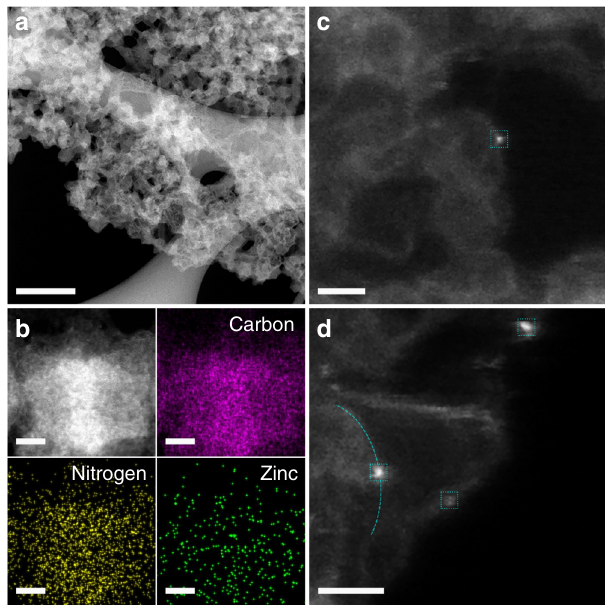
Fig. 4 Structural characterization of ZnNC by atomic resolution scanning transmission electron microscopy (STEM). a , b Low-resolution STEM and element mapping images of ZnNC. c , d Atomic resolution STEM image of ZnNC. The Zn single atoms indexed with cyan blue square, con fi rming that the Zn single atoms are located on the edge of the nitrogenated carbon matrixes. Scale bar: a 200 nm; b 10 nm; c , d 1